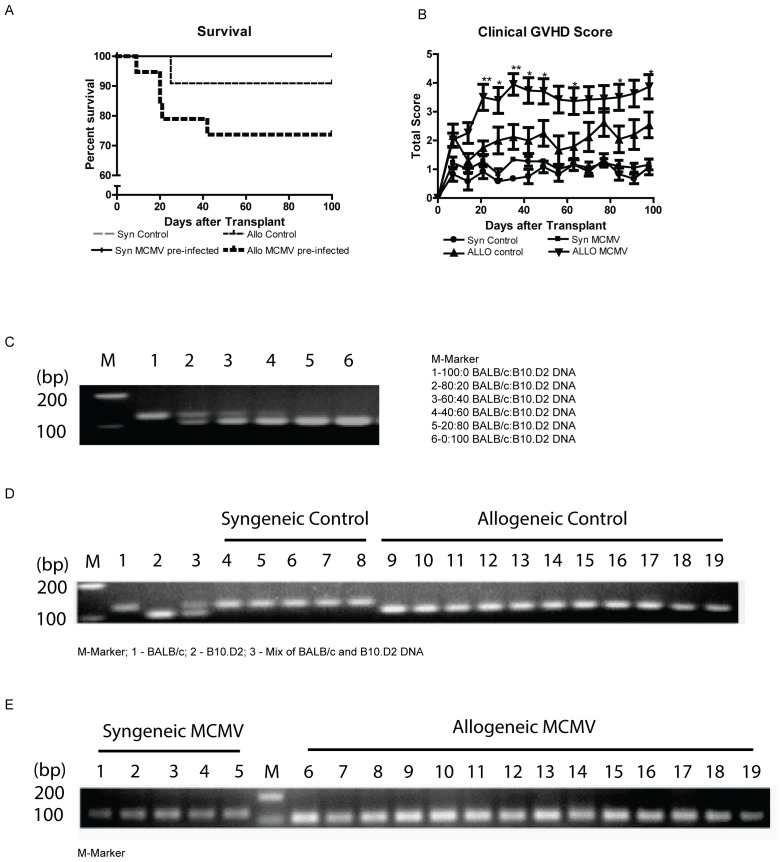
Survival, clinical GVHD and engraftment following HCT.(A+B) Animals were transplanted as described in Materials and Methods, and survival and clinical GVHD scores were monitored for 100 days (n = 6 for syngeneic control group; n = 9 for the MCMV treated syngeneic group, n = 18 for allogeneic control group and n = 19 for the MCMV treated allogeneic group). Data are combined from two identical experiments. (*p<0.005,**p<0.001). (C–E) Detection of gene D2Mit265 PCR products for BALB/c (139 bp) and B10.D2 (103 bp) was used to determine donor cell chimerism in the spleen.